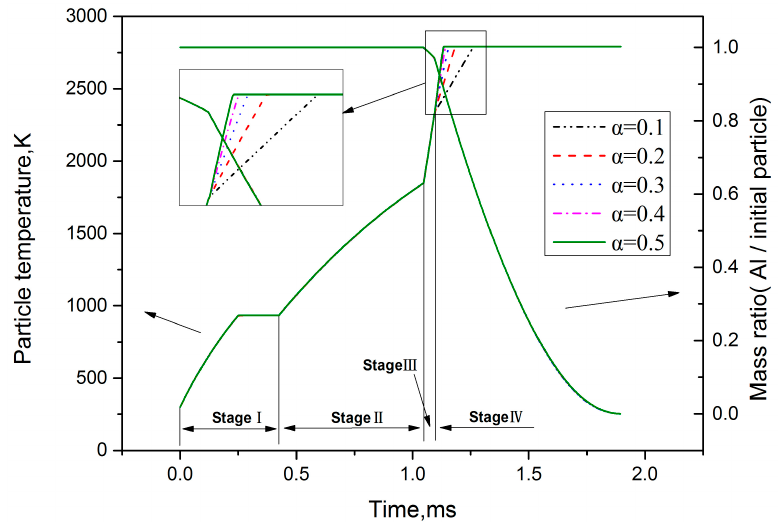
Figure 5. Particle temperature and mass ratio as a function of combustion time for Al particles.